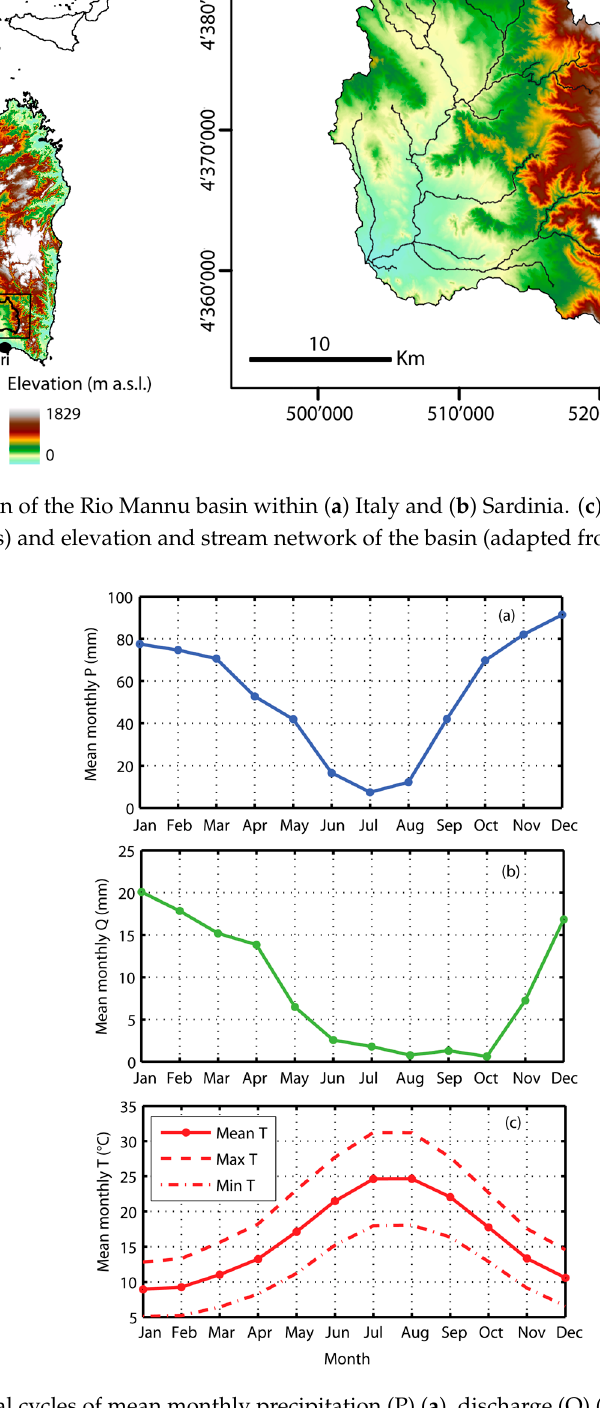
Figure 2. Seasonal cycles of mean monthly precipitation (P) ( a ), discharge (Q) ( b ), and temperature (T) ( c ) in the Rio Mannu catchment.